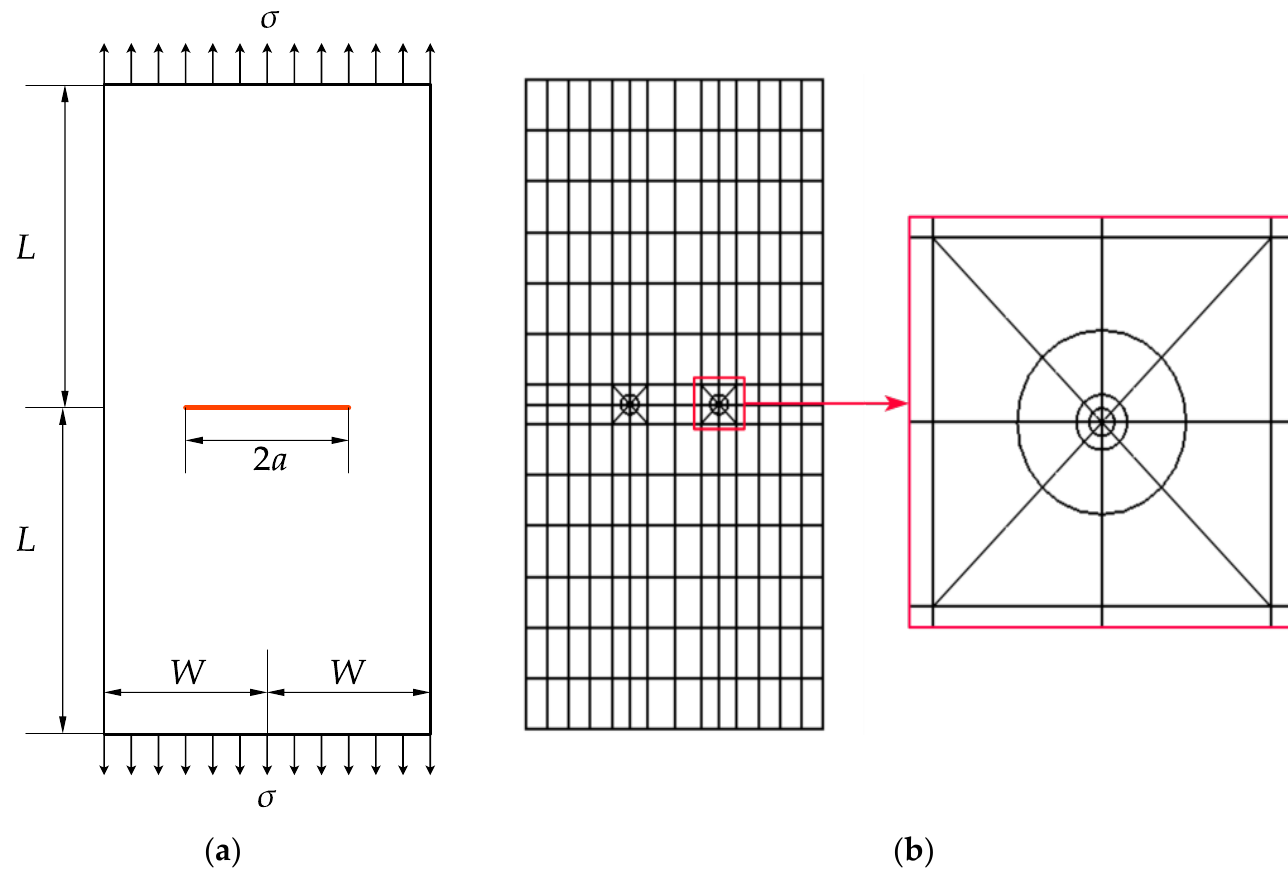
Figure 2. ( a ) A central straight crack plate; ( b ) Global and local meshes (the total number of elements is 252). Table 1. Errors of energy norm of the P-FEM solutions and relative errors of the SIFs K I ( a/W = 0.4, DOF: degree of freedom). p DOF Error of Energy Norm (%) K I ( MPa · m 1 / 2 )